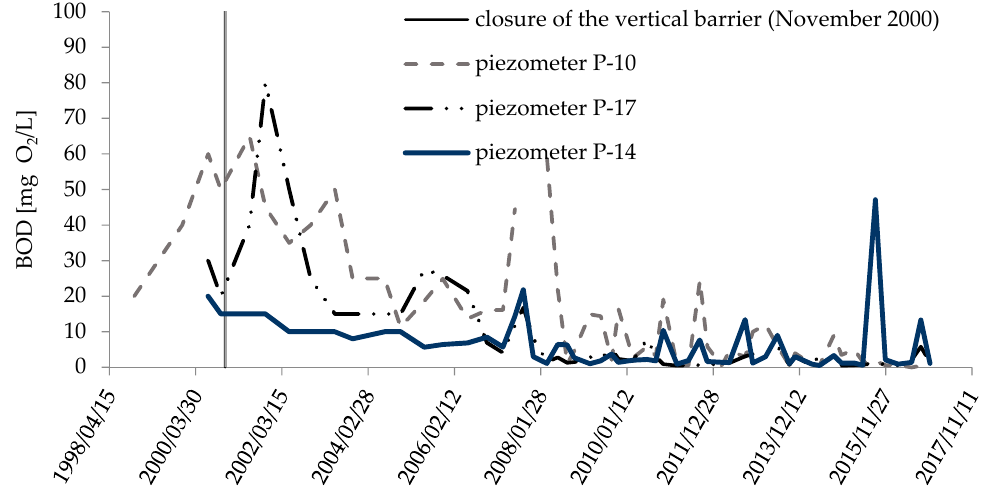
Figure 6. Temporal changes of the BOD level in piezometers located in the area of adjacent facilities.